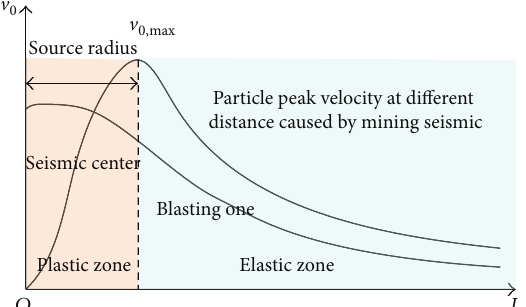
Figure 6: Sketch map of particle peak vibration velocity changing with transmitting distance.